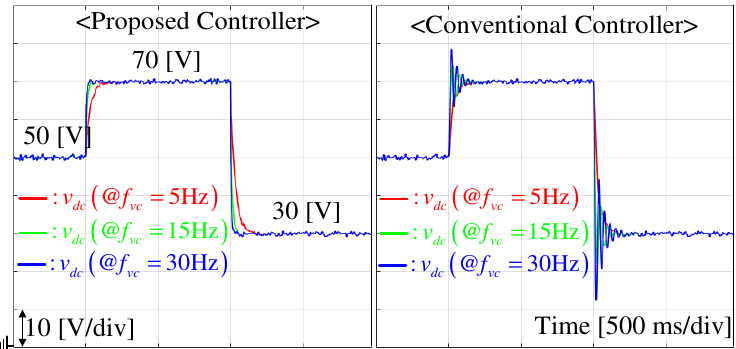
Figure 7. Comparison of output voltage control performance at f vc = 5, 15, and 30 Hz, and pulse reference tracking mode of R L = 20 Ω .